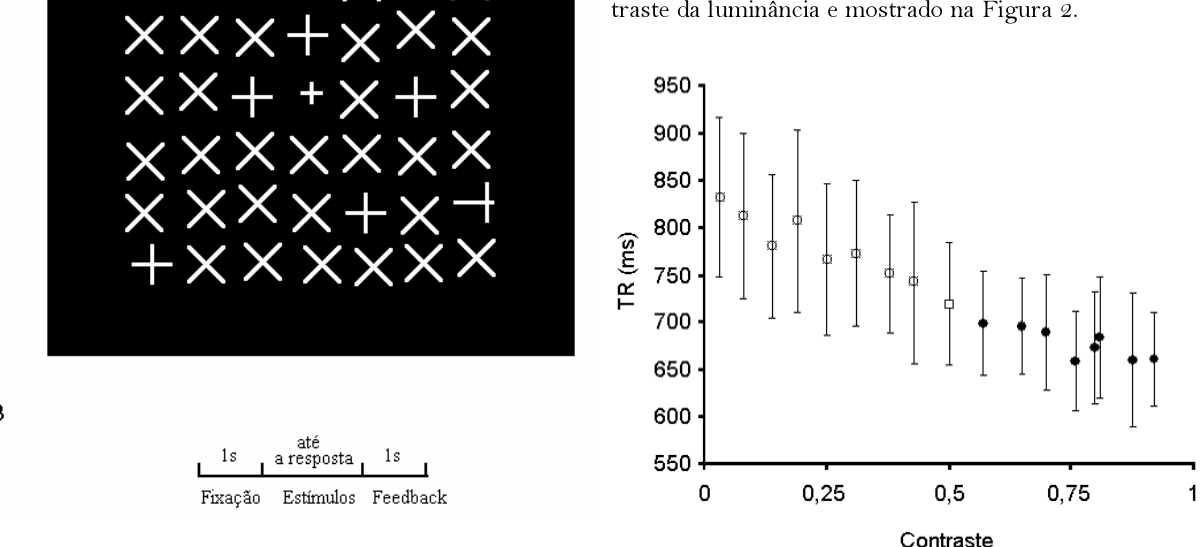
Figura 1 . Representação esquemática dos estímulos apresentados no Ex- perimento 1 e 2. A textura era apresentada com uma luminância menor que os estímulos relevantes. B. Seqüência de eventos apresentados em cada prova.